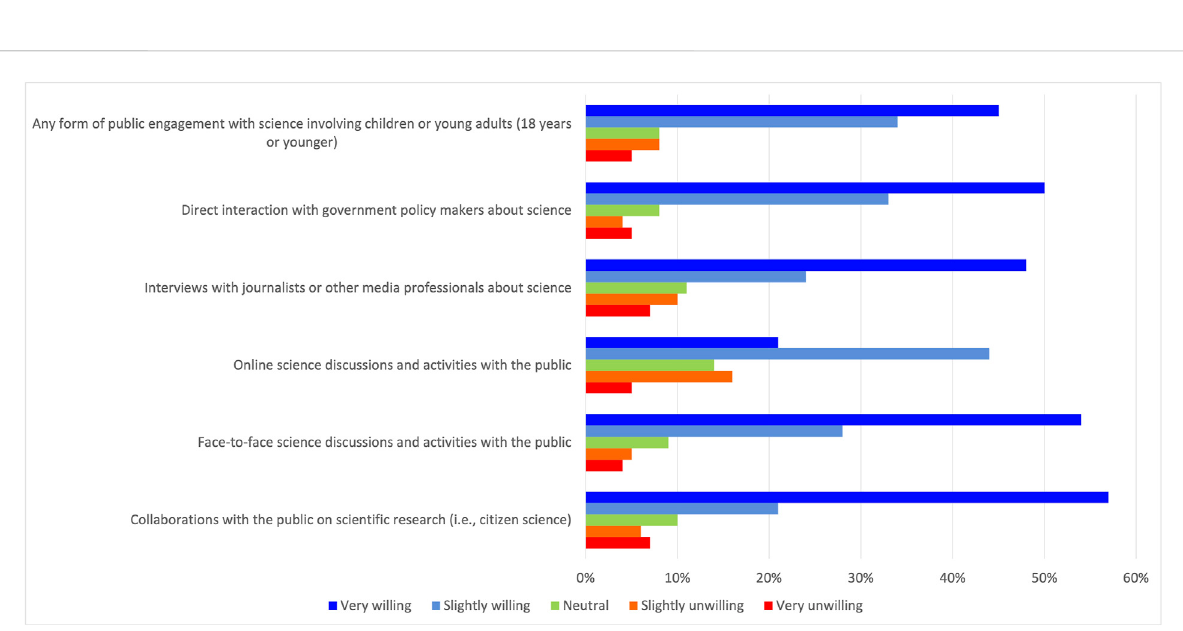
FIGURE 2 Percentage of respondents who are willing/unwilling to participate in different types of public